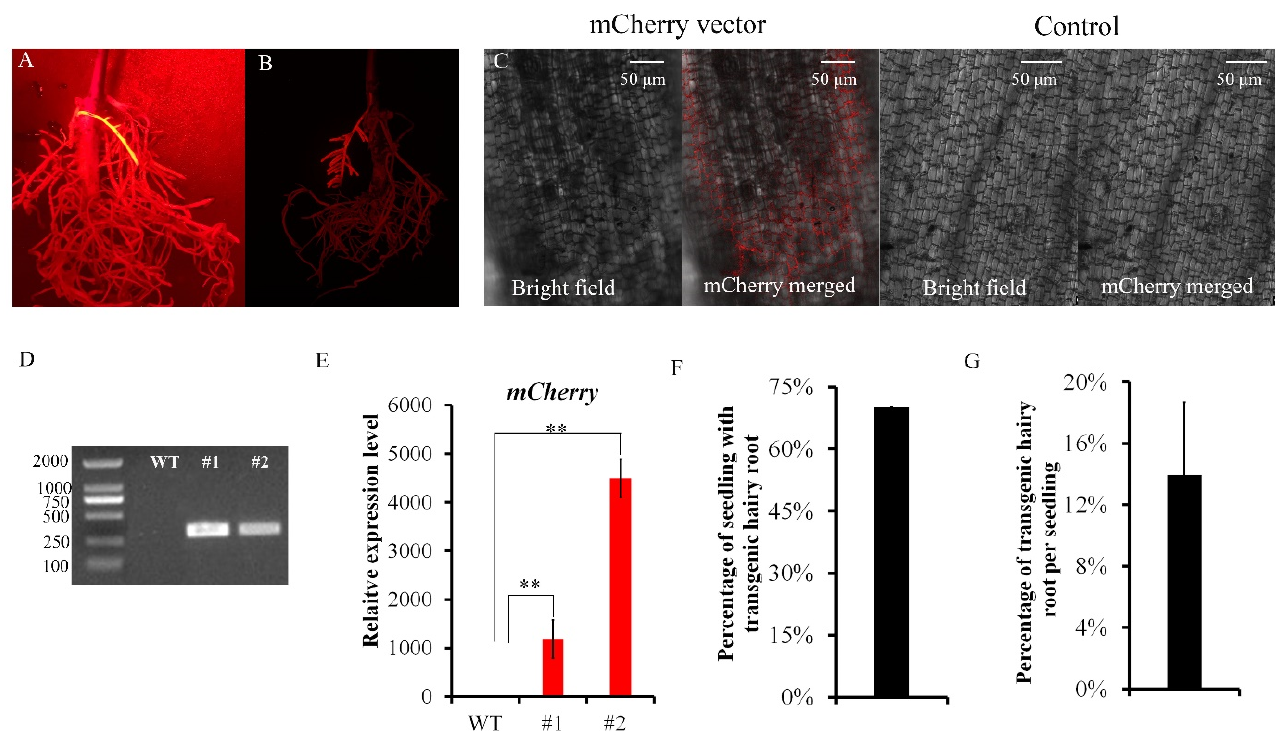
Figure 4. Induction and identification of transgenic hairy roots in the stem of tung tree seedling. ( A , B ) The hairy roots six weeks after injection. Red fluorescence is apparent in transgenic roots. ( C ) Signal for the red fluorescence protein in transgenic hairy roots, as determined by a confocal laser-scanning microscope (excitation wavelength is 633 nm). ( D ) The amplification bands of mCherry genes (coding the DsRed fluorescence protein) based on genomic DNA of transgenic hairy roots and wild-type (WT) roots. ( E ) The relative expression level of mCherry gene in the transgenic hairy roots and WT roots by qRT-PCR amplification. The data present the average of three repeats. ** Two-tailed Student’s t test, p < 0.001. ( F ) . The average fraction of the seedlings producing the transgenic hairy roots. ( G ) The average fraction of the transgenic hairy roots per seedling.